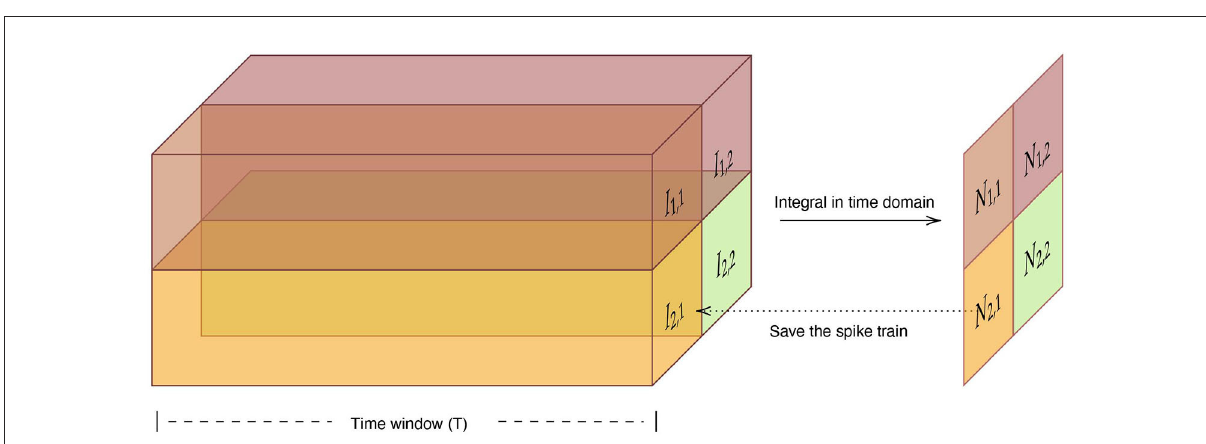
FIGURE15 The structure and information flow of spiking max-pooling